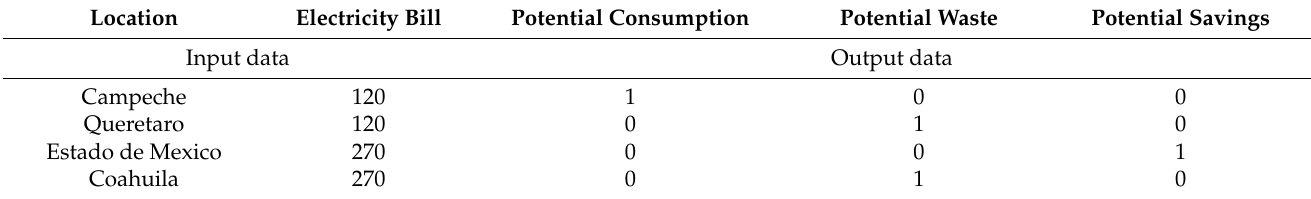
Table 3. Variables considered to build the electricity bill’s